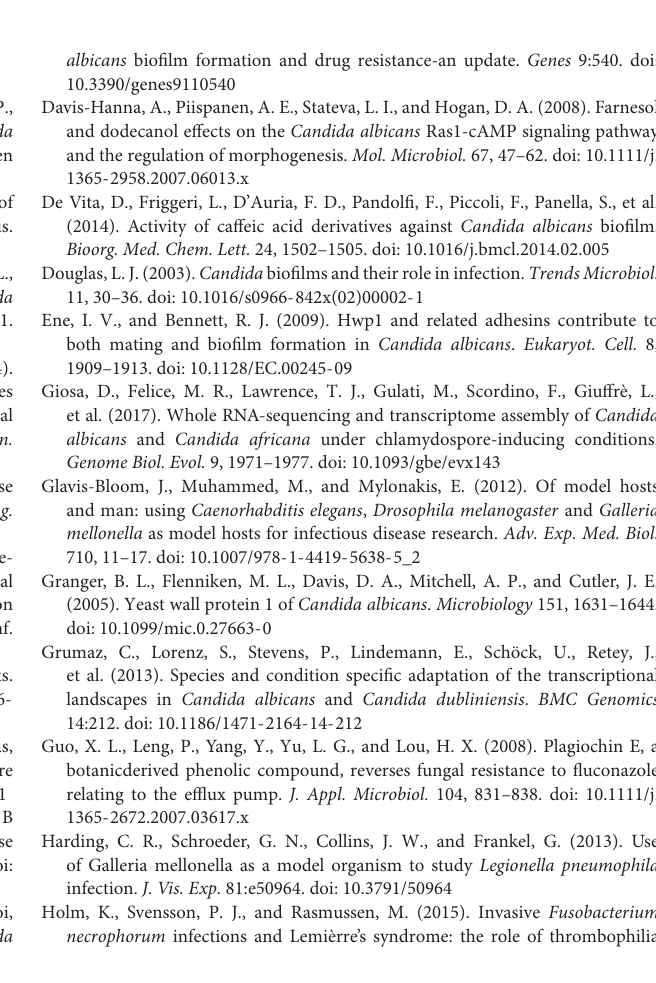
FIGURE S1 | Volcano plot diagram of the extent of the gene differential expression between two groups. FIGURE S2 | Hierarchical cluster analysis of the 611 significantly expression changing genes between two groups. FIGURE S3 | Determination of LD 50 of C. albicans SC5314 strains in G. mellonella larvae. TABLE S1 | Expression changes of several genes in Ras1-cAMP-Efg1 pathway determined by transcriptomic analysis. TABLE S2 | Complete list of genes with significantly expression changes determined by transcriptomic